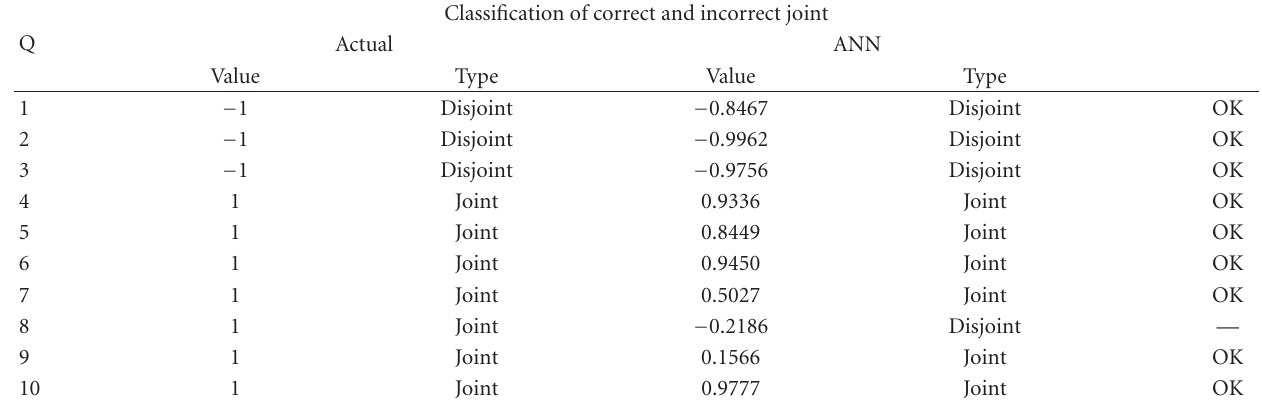
Table 2: Simulation results in case study.